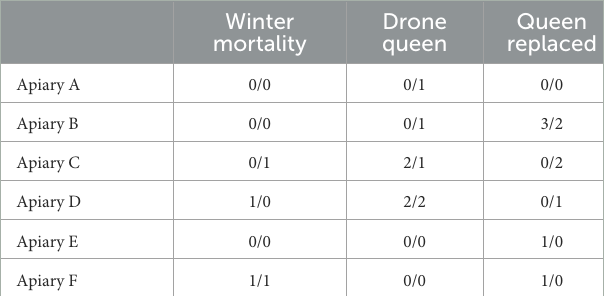
TABLE 1 Number of queens failing due to different causes during the experiment in each apiary and the treatment (control/priming).